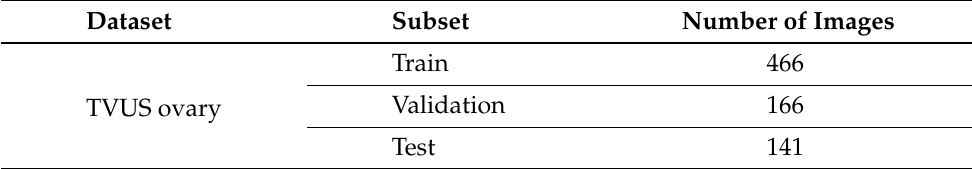
Table 1. TVUS ovarian dataset split into the three